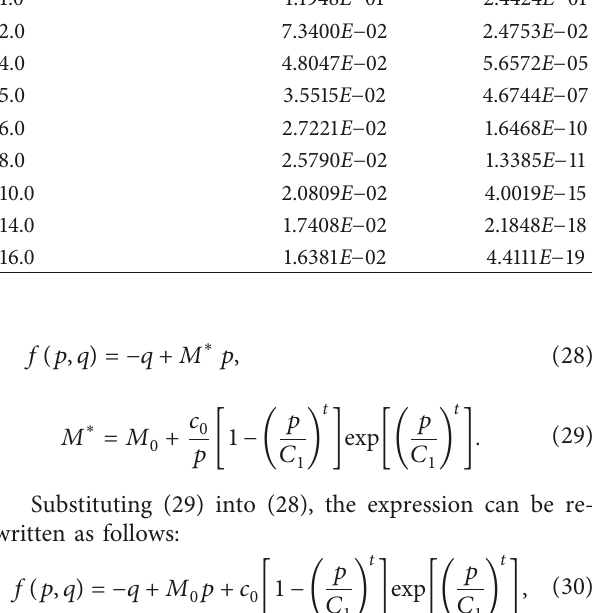
Figure 9: The predicted results of the bulk modulus K (a) and shear modulus G (b) with experimental data.